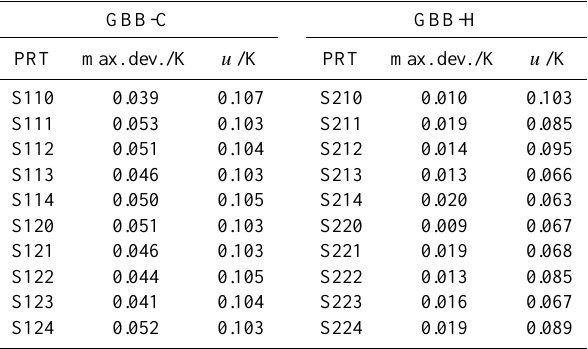
Fig.12. Deviation(residuals)ofthemeasuredradiationtemperaturefromthecalibrationcurveatthemeasuredresistancevalues(correspond- ing to temperature steps of 5 ◦ C from − 50 ◦ C to 0 ◦ C) for two selected PRTs. (a) PRT S124 (GBB-C) which showed the largest deviation of a calibration point from the fitted calibration curve in the January 2013 calibration campaign, (b) PRT S210 (GBB-H) which showed the smallest deviation of all calibration points from the fitted calibration curve in the January 2013 calibration campaign. J. Name, 1, 1–20, 2013 www.jn.net/1/1/2013/